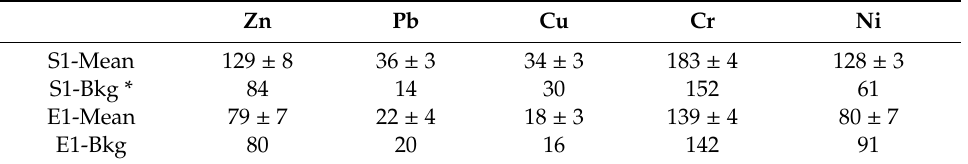
Table 2. Mean and standard deviation of trace metals in S1 and E1 sediment cores (ANOC-2016) and background (Bkg)